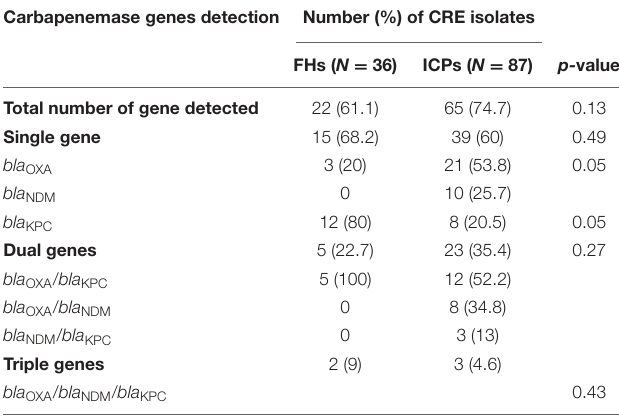
TABLE 3 | Prevalence of mediating carbapenem resistance genes in isolates from food handlers and infected control patients. Carbapenemase genes detection Number (%) of CRE isolates FHs ( N = 36) ICPs ( N = 87) Total number of gene